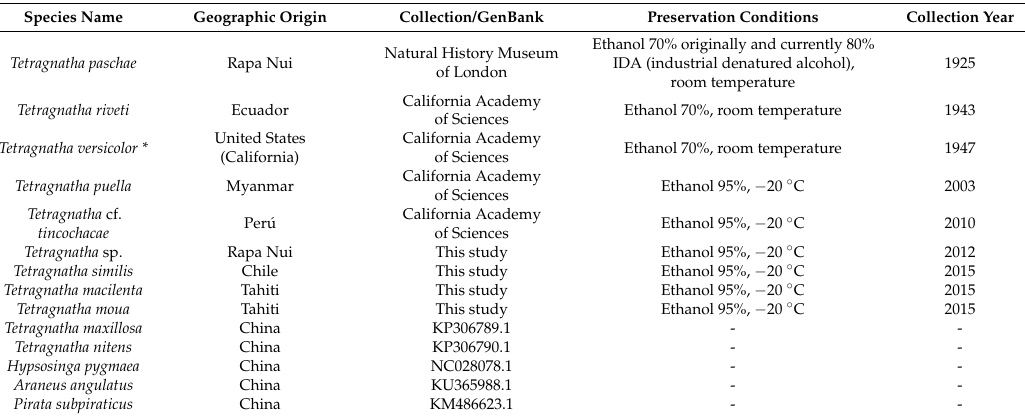
Table 1. Species included on the